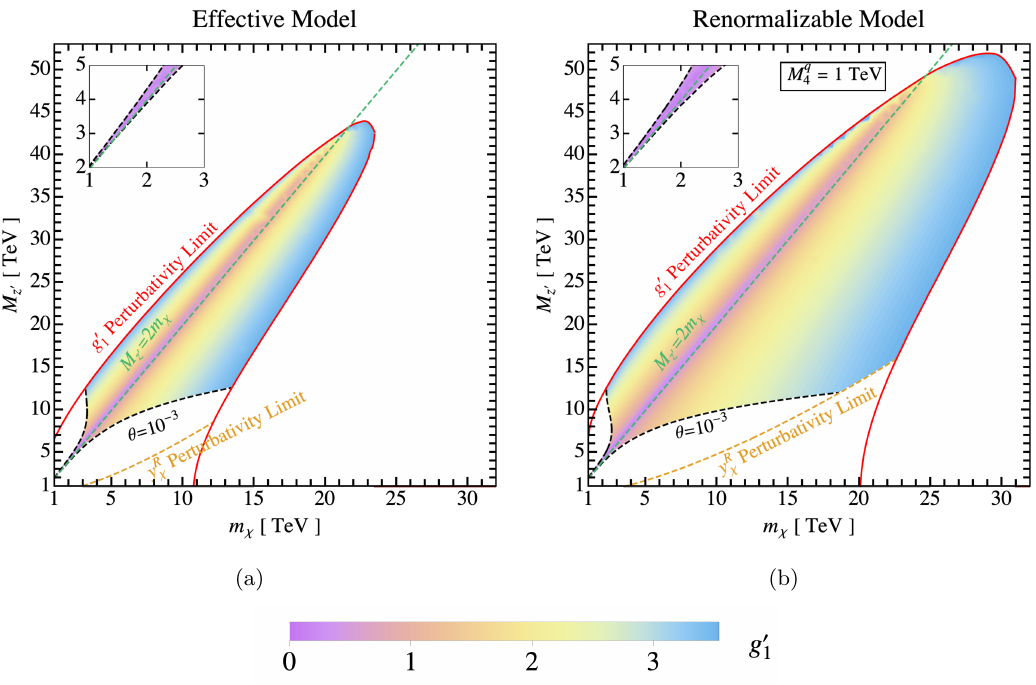
Figure 3 . Allowed values of U(1) 0 gauge coupling for different masses of dark fermion and U(1) 0 gauge boson in the effective model (left panel) and renormalisable